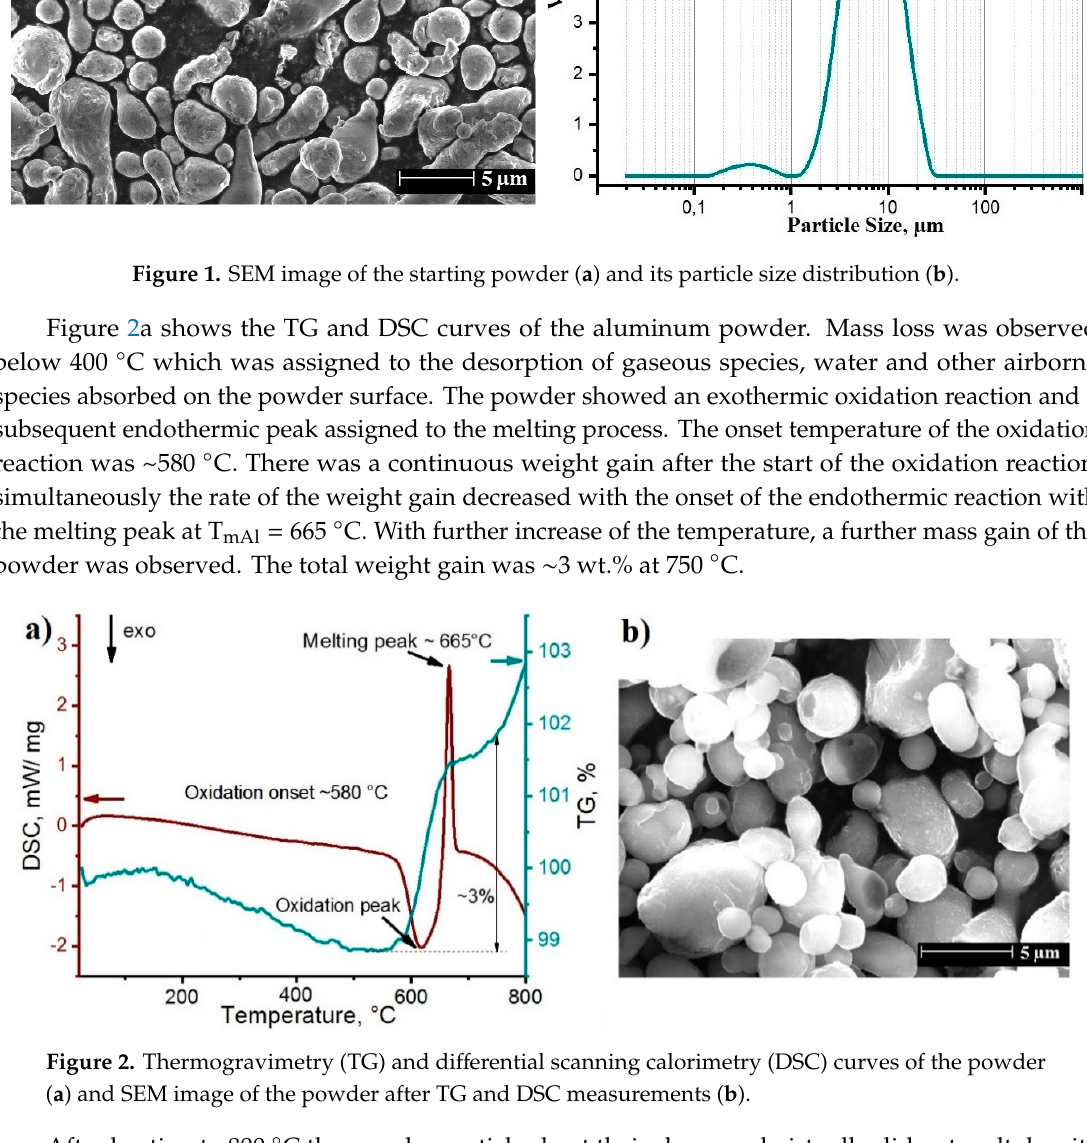
Figure 1. SEM image of the starting powder ( a ) and its particle size distribution ( b ).